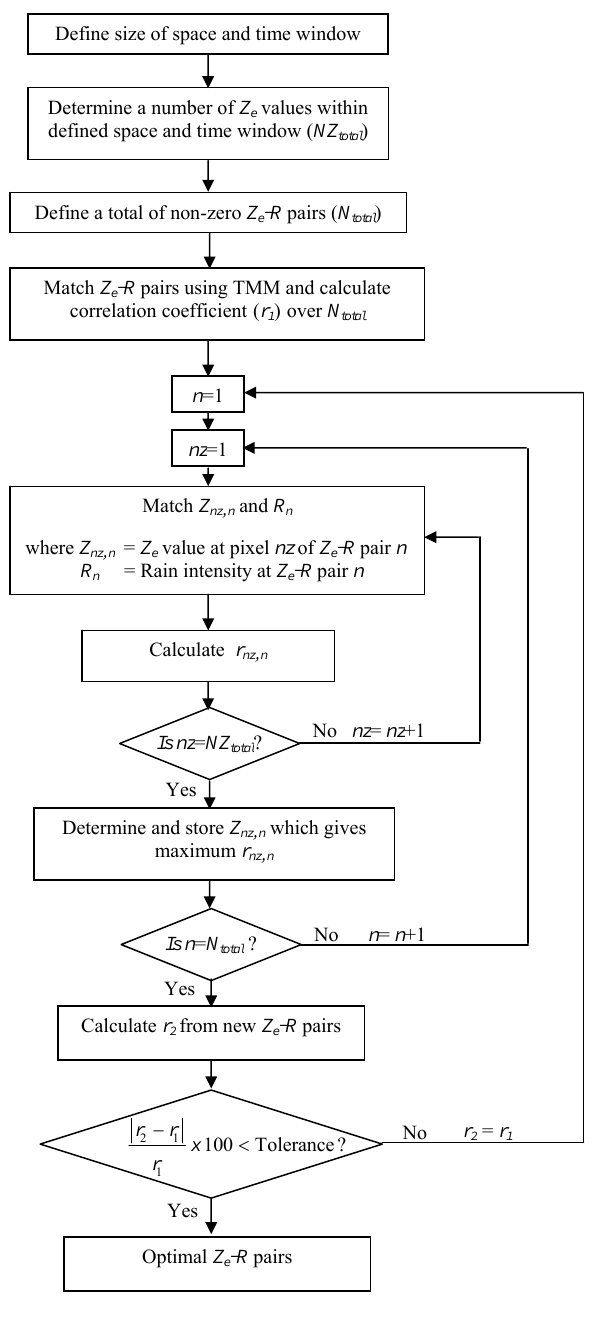
Figure 6. Fig. 6. The WCMM process.